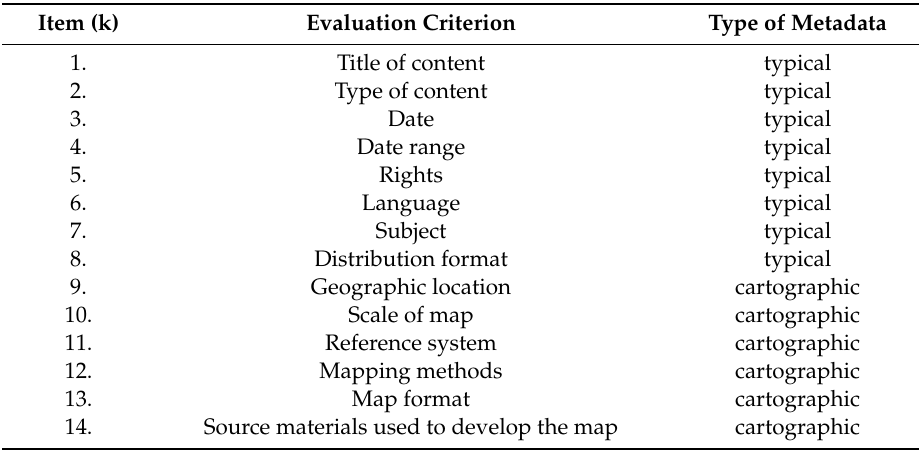
Table 1. Metadata scope pattern (modified scope pattern from